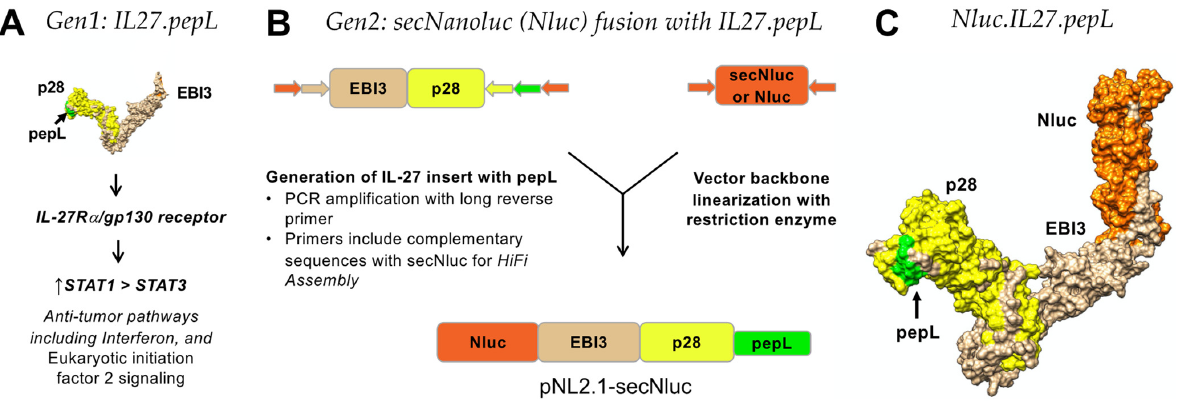
Figure 1. Development of IL-27 chimeric cytokines. ( A ) Generation 1 (Gen1) of IL-27 (IL27p28 and EBI3 subunits) with pepL at the C-terminus. Antitumor pathways listed briefly summarize the signaling effects reported in [8]. ( B ) Generation 2 (Gen2) of the IL27.pepL consists of its fusion at the N-terminus to a secreted Nanoluc (Nluc). Shown is the vector evolution of targeted Nanoluc-27 (Nluc-27.pepL). Mouse IL-27elasti fragment from pUNO1-mIL-27(ebi3p28) (InvivoGen) with a 3 ′ insertion of a sequence-encoding peptide linker (GGGGS) (not shown) followed by the sequence for the targeting peptide (pepL: LSLITRL), lime green; scrambled control (scr1: IRSLTLL), not shown; or irrelevant-peptide control (irrel1: SIFSSHM), not shown. pNLF1-secNluc (Promega) was used as the vector backbone and was linearized using EcoRI. NEBuilders HiFi DNA-assembly cloning kit (#E5520S) was used to generate plasmids with the fusions of Nluc and targeted IL-27-expression vectors. ( C ) In silico modeling of the final construct of Nluc-27 (I-TASSER) showing the targeting module (pepL) is solvent exposed (lime green).